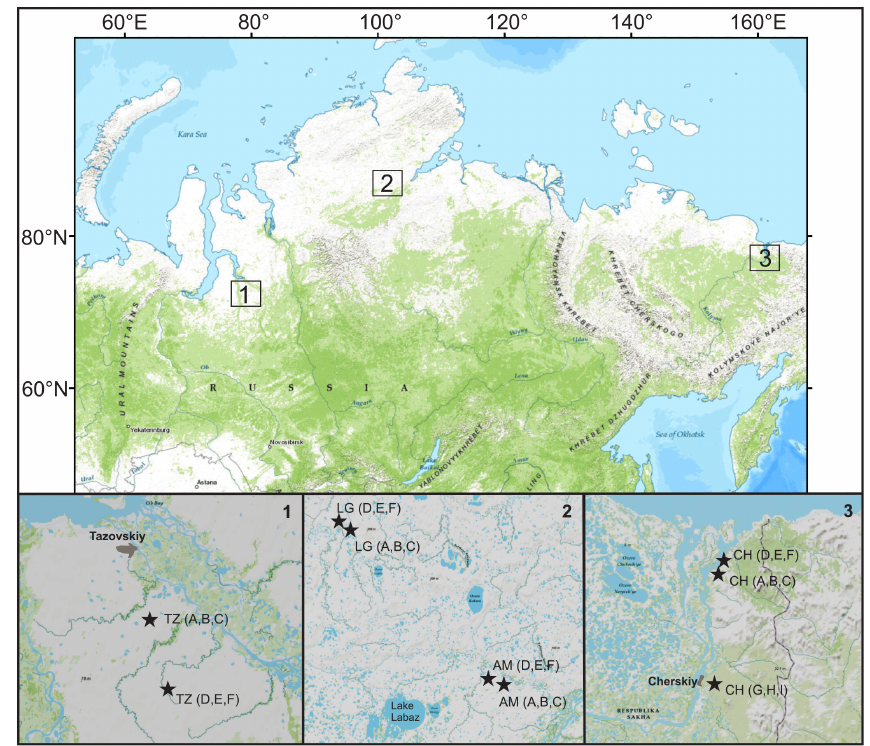
Figure 1. Sampling locations in western Siberia (1), central Siberia (2), and the Taimyr Peninsula and eastern Siberia (3). Each star marks a sampling site with three replicate soil profiles. Abbreviations are as follows: CH, Cherskiy; AM, Ari-Mas; LG, Logata; TZ, Tassovskiy (generated by ArcGIS 10).